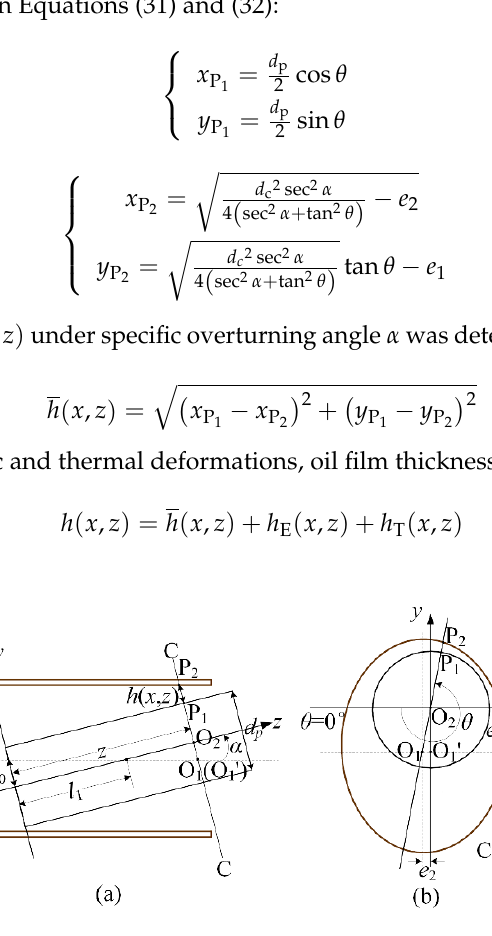
Figure 6. Graph of calculation of oil film thickness: ( a ) Axial section view; ( b ) Bottom view.